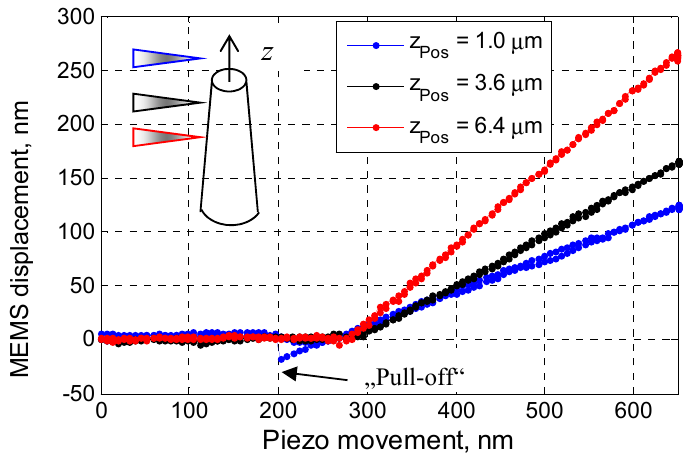
Figure 8. Bending tests of a nanopillar at di ff erent ∆ z -positions. From the slope of the curves ( S b ( z )) the